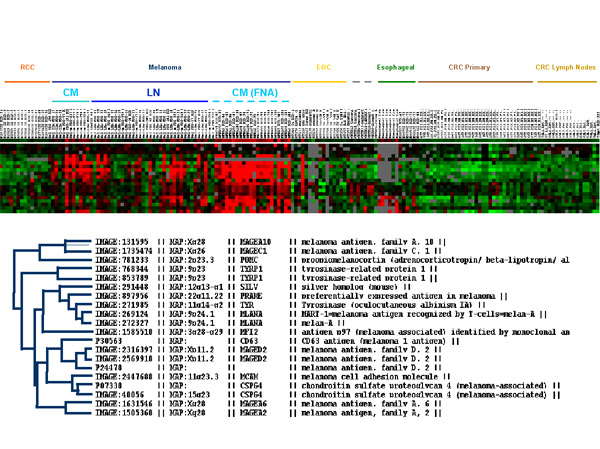
Eisen's clustering of genes already reported to be preferentially expressed by melanomas. The analysis was performed on 180 cancer samples as described in the Results section and ordered according to Table 1. In particular, renal cell cancer (RCC, orange), melanoma (blue), Epithelial Ovarian Cancer (EOC, yellow), Esophageal Cancer (green), Primary Colorectal Cancer (CRC, dark brown) and lymph nodal metastases of CRC (light brown) are shown. Melanoma samples are further subdivided in cutaneous metastases (CM, light blue) from frozen sections (continuous line) or fine needle aspirates (FNA, dashed line) and lymph nodal metastases (LN, darker blue line). Below is the distance among the various genes based on Eisen's clustering.